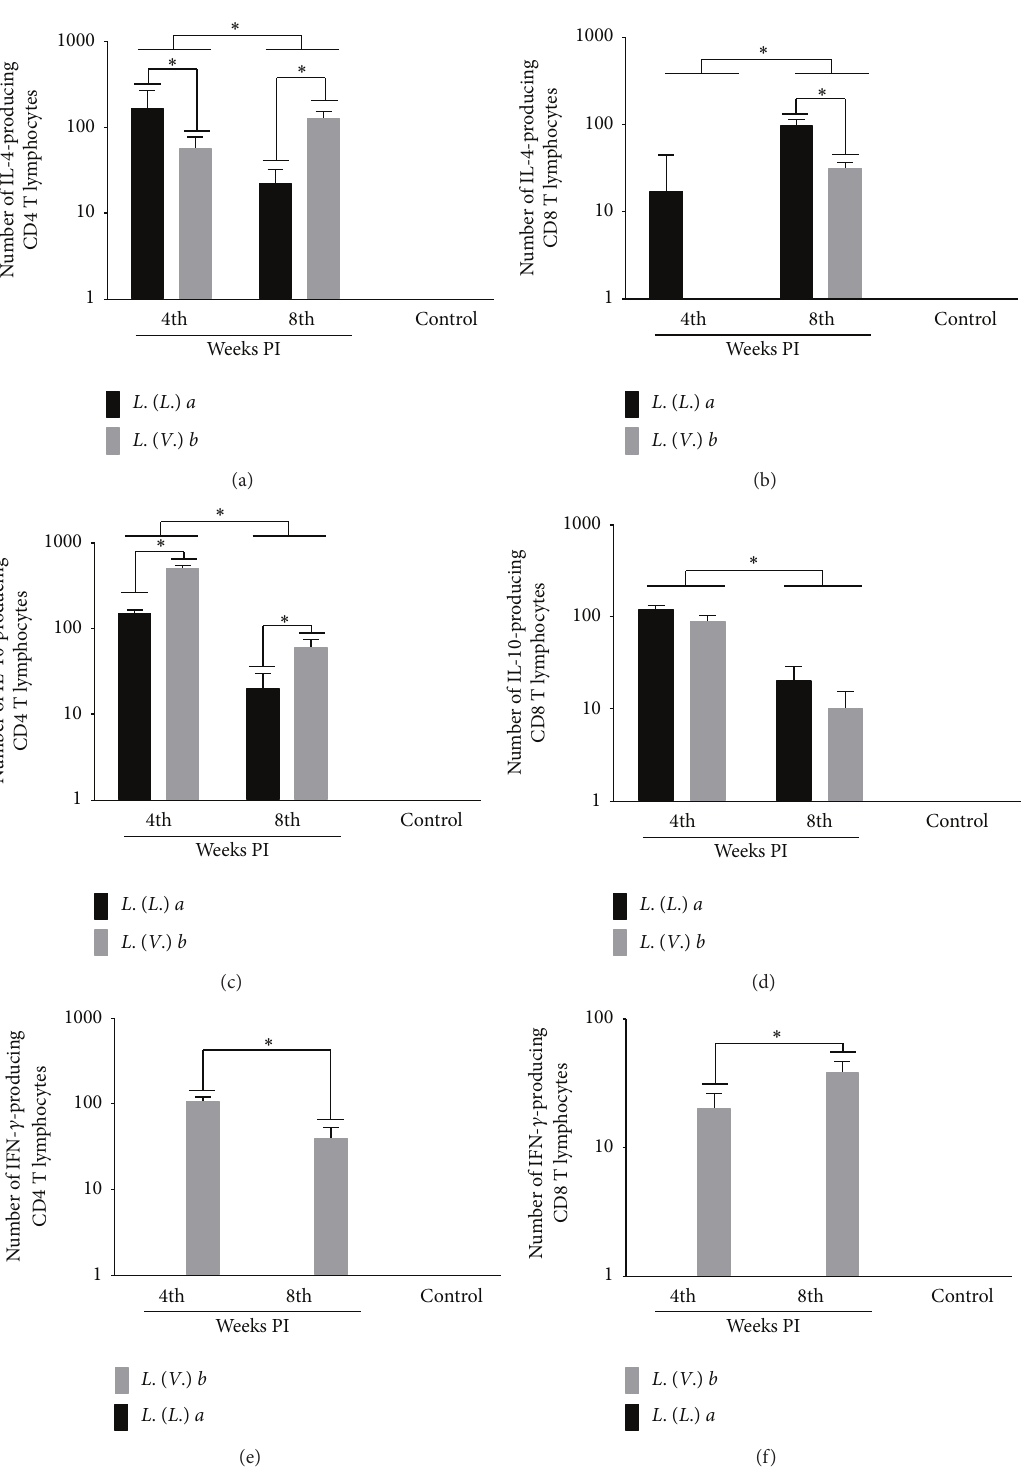
Figure 5: IL-4-, IL-10-, and IFN- 𝛾 -producing CD4 + and CD8 + T-cells from the popliteal lymph nodes of BALB/c mice infected with L. (L.) amazonensis or L. (V.) braziliensis . (a) Number of IL-4-producing CD4 + T-cells. (b) Number of IL-4-producing CD8 + T-cells. (c) Number of IL-10-producing CD4 + T-cells. (d) Number of IL-10-producing CD8 + T-cells. (e) Number of IFN- 𝛾 -producing CD4 + T-cells. (f) Number of IFN- 𝛾 -producing CD8 + T-cells. Data represent the mean ± SD of three independent experiments. ∗ 𝑝 < 0.05